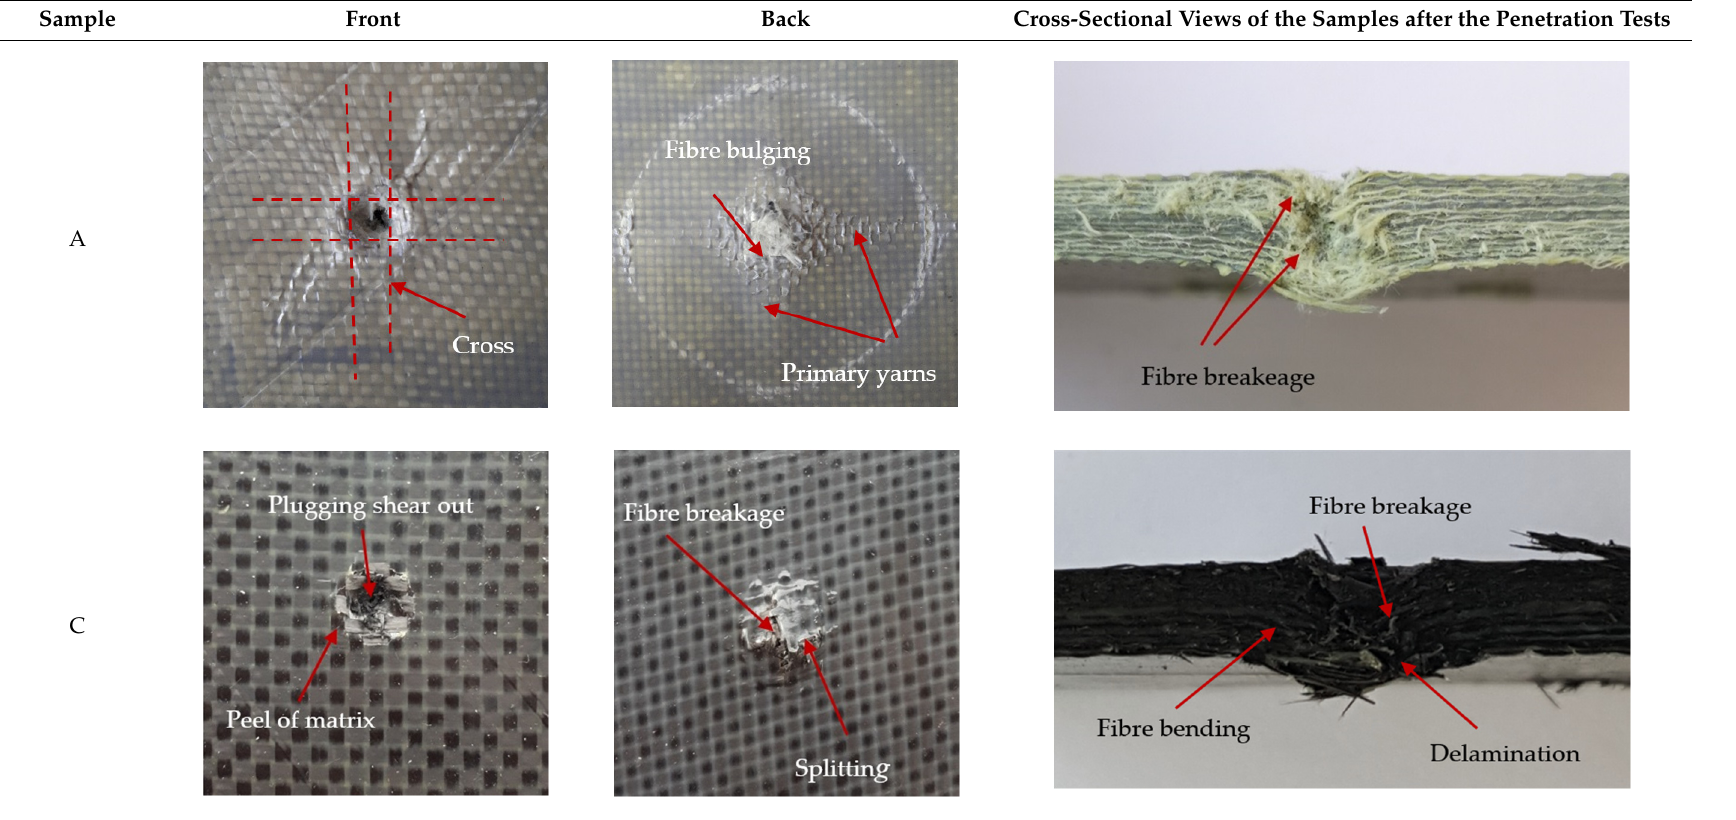
Table 4. Front and back views of the samples after the penetration tests.